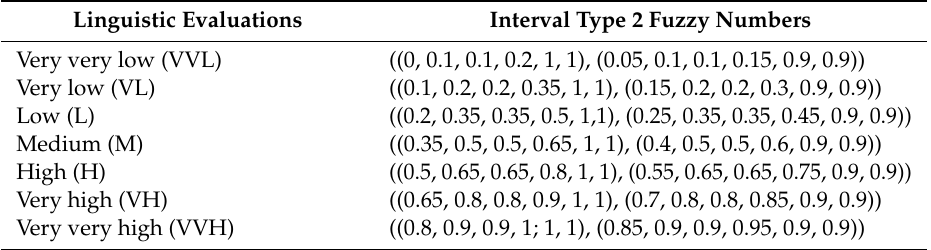
Table 2. Scales and fuzzy numbers for evaluations.